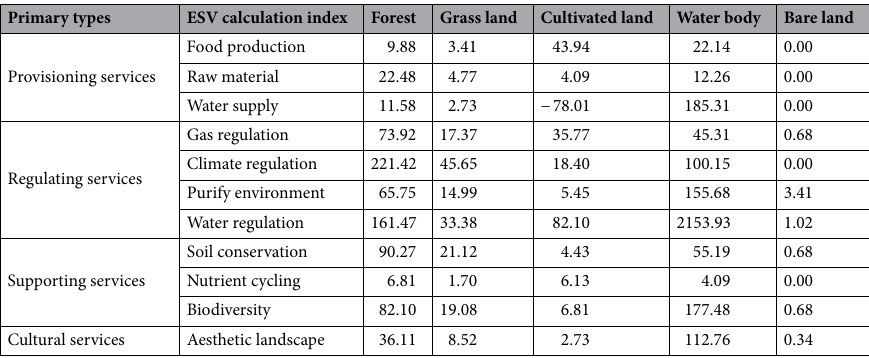
Table 2. Parameters of ESV for different land use types in the main urban area of